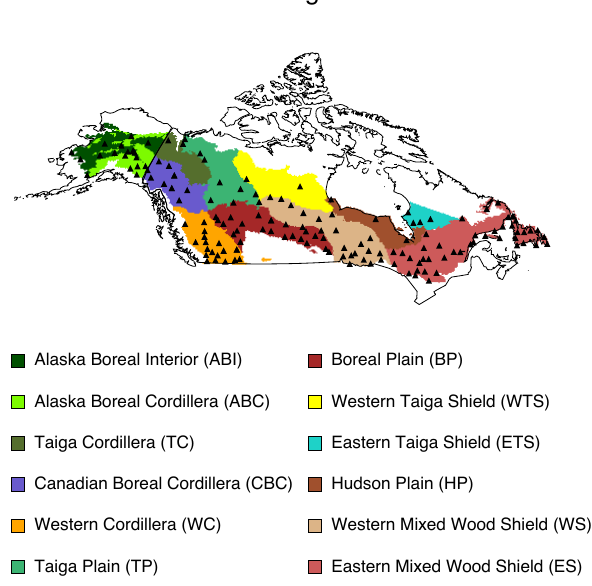
Figure 1. Distribution of the 12 ecoregions used for this study. The black triangle symbols indicate the GSOD meteorological data sites in Alaskan and Canadian